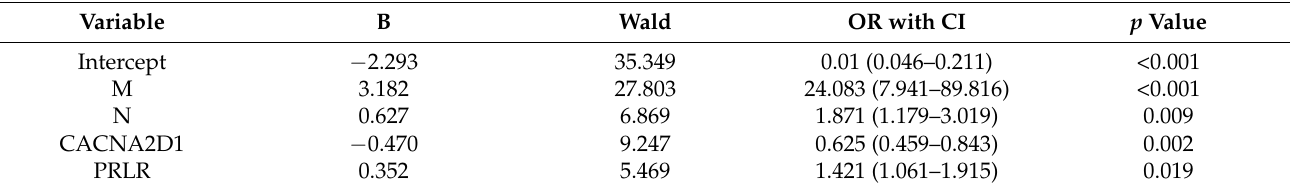
Table 2. Variables and their parameters in the model.